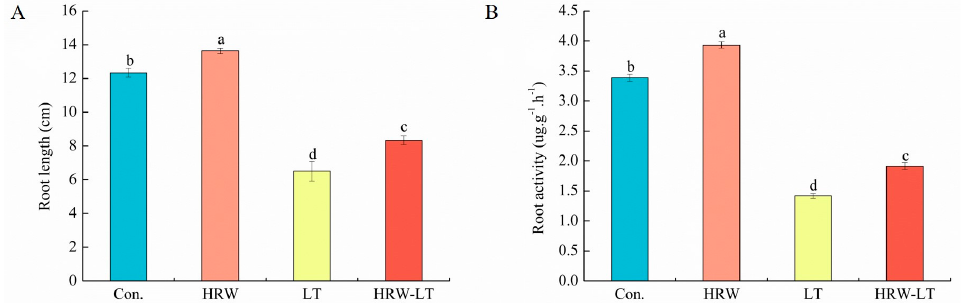
Figure 3. HRW enhanced root system under chilling stress. ( A ) root length; ( B ) root/shoot ratio. Values are the means ± SD, n = 9 (number of samples). The different letters indicate a significant difference ( p < 0.05). These indicators were measured after 72 h of chilling stress.